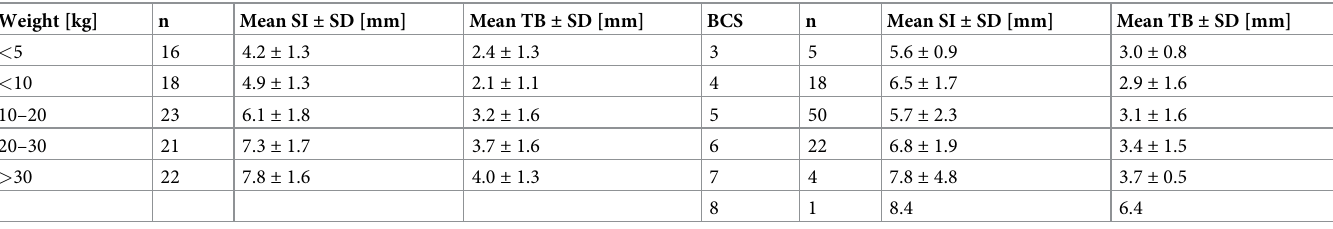
Table 7. Mean values and SDs for SI and TB in dogs classified by weight [kg] and BCS. Weight [kg]